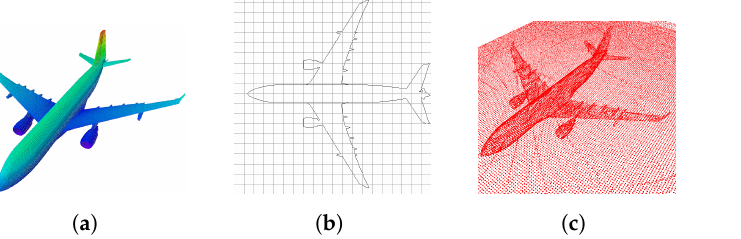
Figure 1. Kind of maps to be used. ( a ) Three-dimensional Occupancy grid Map (Octomap). ( b ) Two-dimensional Occupancy grid Map. ( c ) Graph SLAM map.